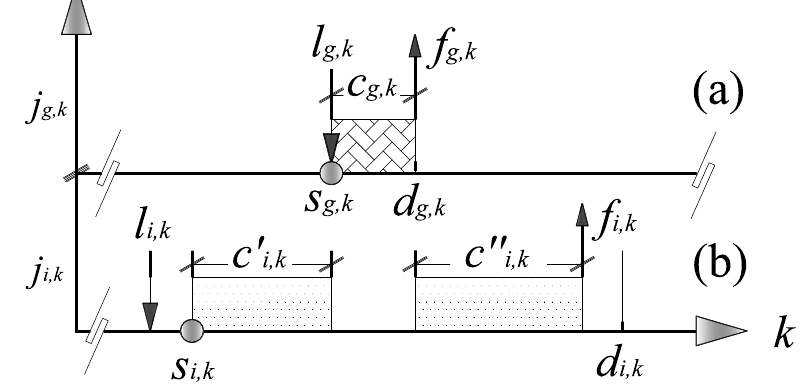
Figure 4. ( a ) General approach to the characterization of the execution times of the RTT instances. ( b ) Specific approach based on the eviction of the RTT due to scheduler; where c (cid:48) execute time obtained by the eviction of the j i , k .